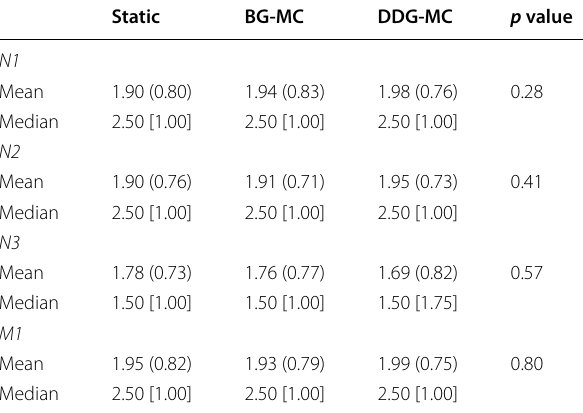
Table 4 Up- or downrating in consensus by the readers between different image reconstruction methods